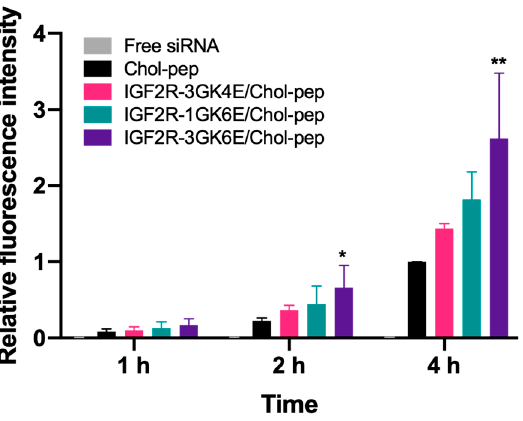
Figure 4. Quantitative cellular uptake of IGF2R peptide-modified nanocomplex in HSC-T6 cells. The cells were incubated with a nanocomplex loaded with Cy5-labeled Pcbp2 siRNA for 1, 2, and 4 h, followed by flow cytometry analysis. Results are presented as the mean ± SD ( n = 3) (* p < 0.05; ** p < 0.01).